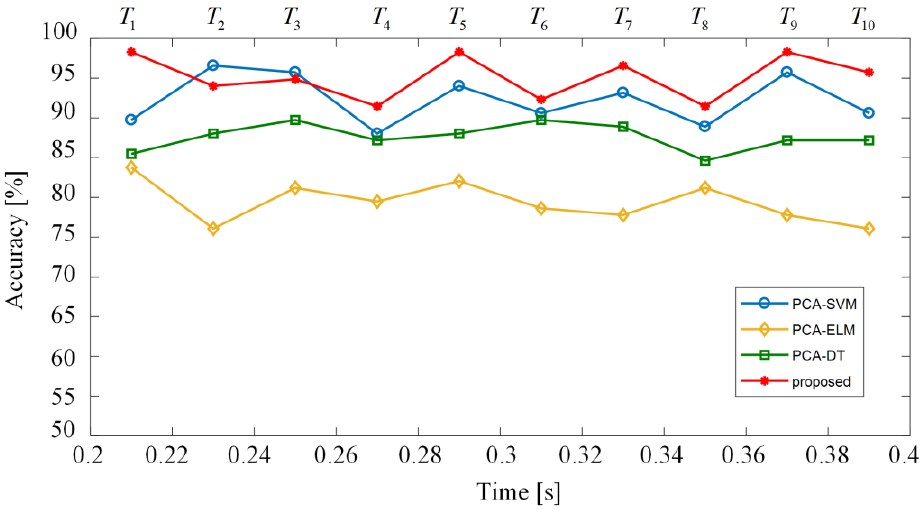
Figure 9. Accuracy of different fault diagnosis strategies for 10 periods.